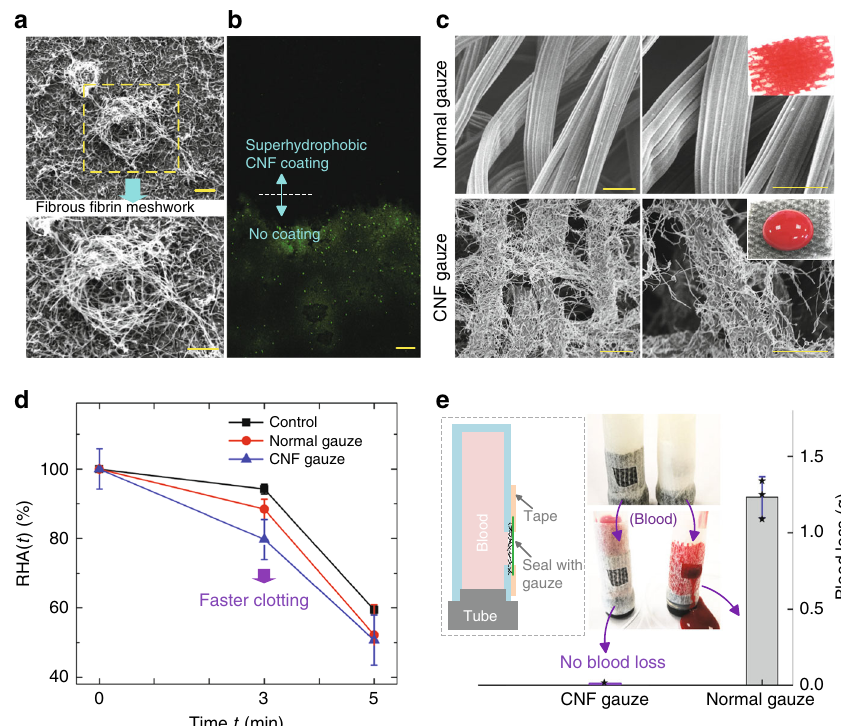
Fig. 3 Anti-bacterial, rapid coagulation, and non-wetting features. a Fibrous fi brin meshwork formed on the superhydrophobic CNF/PTFE Ti surface. b Anti-bacterial capability; after fl ushing with fl uorescent bacteria solution, nearly no bacteria (green dots) were observed to attach on the superhydrophobic CNF surface under the microscope with green fl uorescent protein excitation. c SEM images of the normal gauze and the CNF gauze; the normal gauze is superhydrophilic and blood absorbing; the CNF gauze has a dense layer of CNF coating and repels blood. d The relative hemoglobin absorbance RHA( t ) plot, showing the fast clotting performance of the CNF gauze; as the experiment was performed in a petri dish, clotting in the petri dish without any gauze was used as control; the absolute hemoglobin absorbance at clotting time t , HA( t ), was measured by the spectrometer at 540nm ( n = 3); HA(0), the hemoglobin absorbance at t = 0min, was used as the reference; the relative hemoglobin absorbance at clotting time t , RHA( t ) equals to HA( t )/HA(0); as the hemoglobin came from unclotted red blood cells, a lower hemoglobin absorbance value would mean faster clotting. e Clotting without blood loss ( n = 3); the CNF gauze was used to seal an opening on a silicone tube, mimicking a skin wound covered by a gauze; individual data points are represented by black stars. The CNF coating was in contact with blood in d and e . Scale bars are 10 μ m in a , 50 μ m in b , and 20 μ m in c . Data in d and e are shown as mean ±SD, and the error bar represents SD. Source data for d and e are provided as a Source Data fi